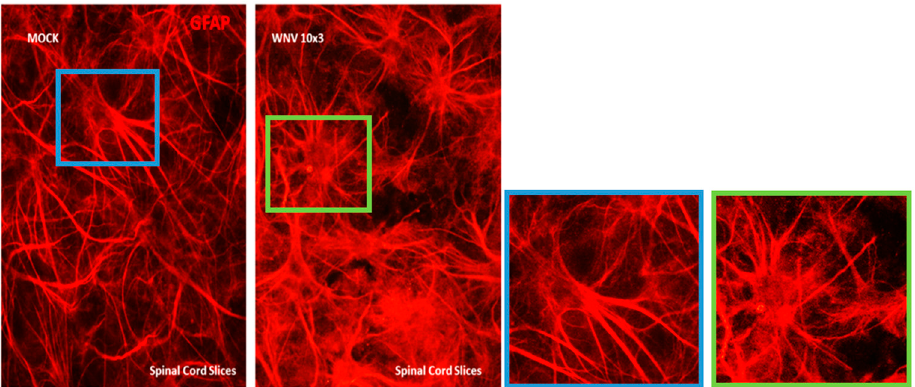
Figure 1. GFAP-immunostained spinal cord slice cultures (SCSCs), mock- or West Nile virus (WNV)-treated (10 3 PFU). Compared to mock, cultures exposed to WNV showed increased GFAP immunoreactivity and marked changes in astroglial morphology (see zoomed in images in blue and green squares for mock and WNV-treated SCSC, respectively). 181